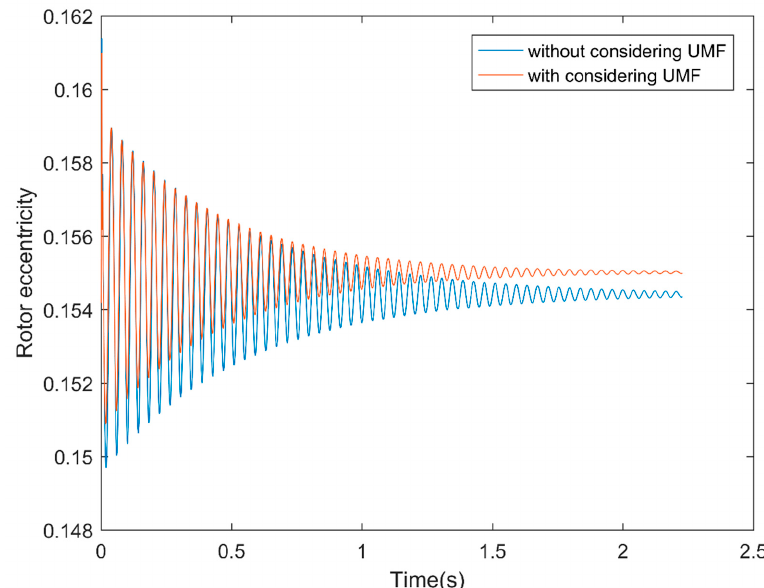
Figure 12. Rotor eccentricity variation with and without considering the UMF. Figure 12.